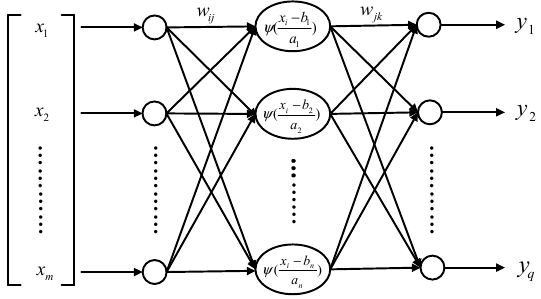
Figure 3. Fault diagnosis model based on the wavelet neural network.